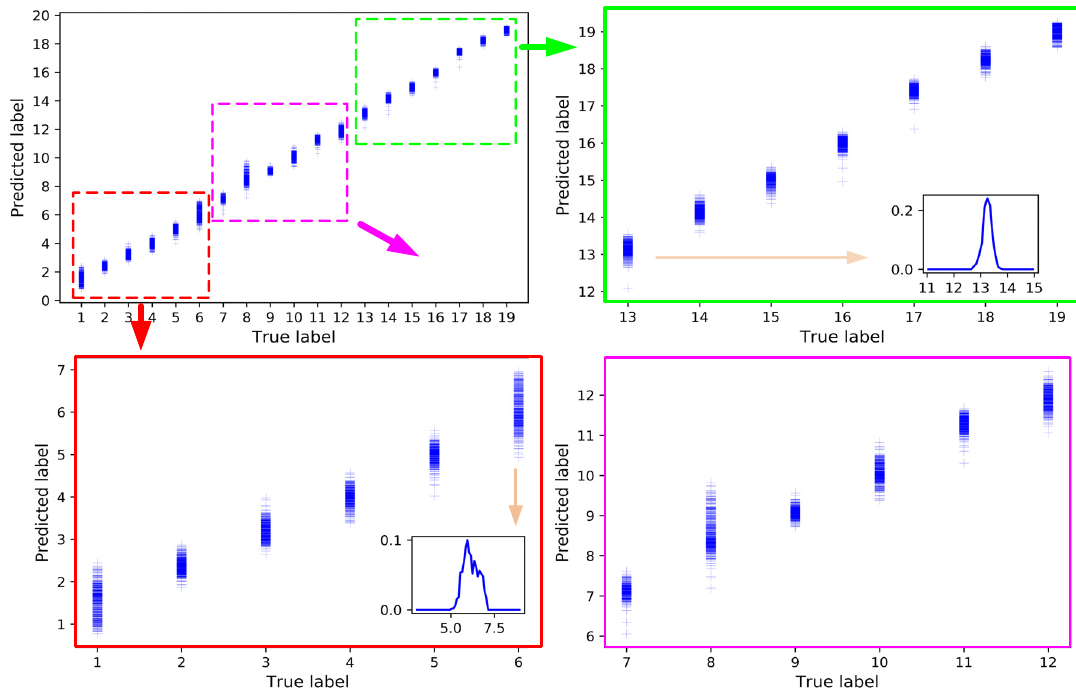
Figure 10. Prediction results LSTM model.